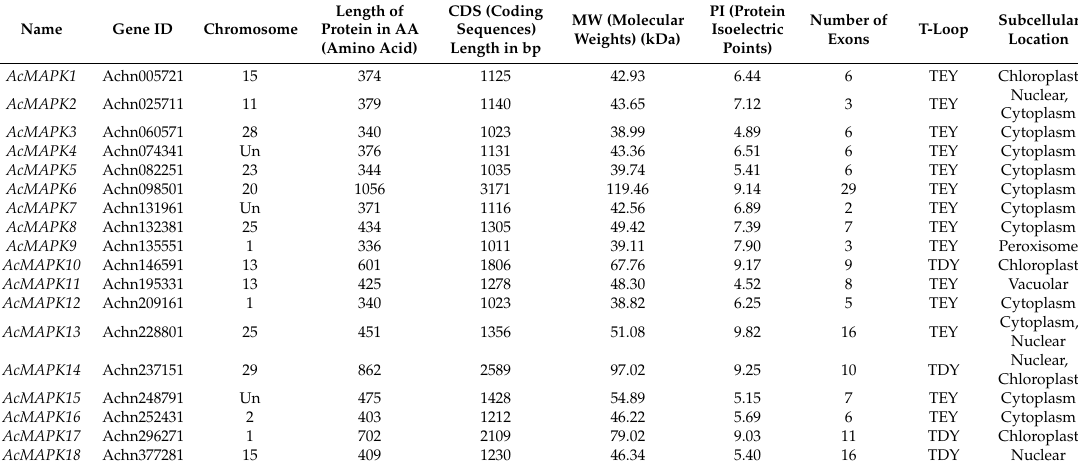
Table 1. The characteristics of putative MAPK genes in kiwifruit.